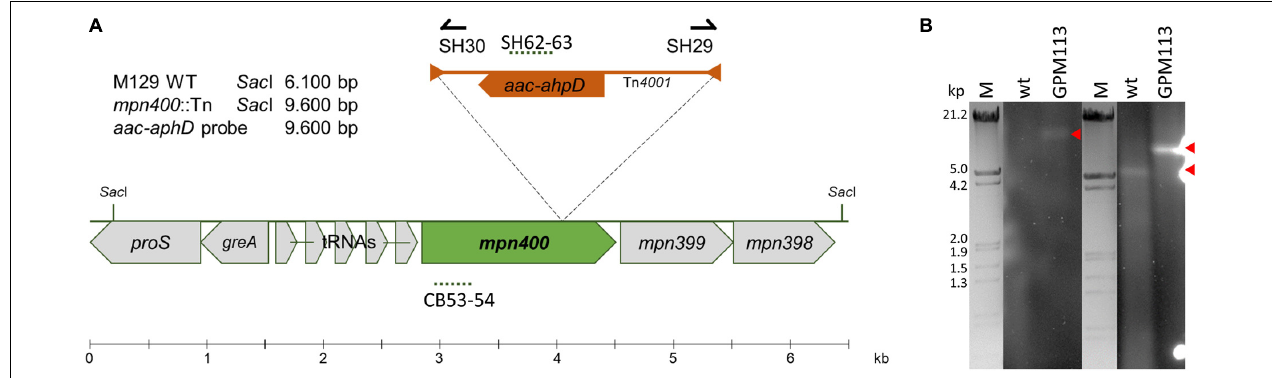
FIGURE 3 | Isolation of a mpn400 transposon insertion mutant. (A) Schematic representation of the genomic region of mpn400 in M. pneumoniae and the transposon insertion site in the mpn400 :Tn- 4001 mutant GPM113. The location of the probes is indicated by dashed lines. (B) Southern blot analysis to confirm single transposon integration using chromosomal DNA of the wild type (wt) and strain GPM113 were digested using Sac I. Detection was carried out with a probe specific for the aac-ahpD resistance cassette and a probe hybridizing to the gene mpn400 (right) which is upshifted after transposon integration. The relevant bands are highlighted by red arrows. λ -marker ( Hin dIII/ Eco RI) served as a size standard.